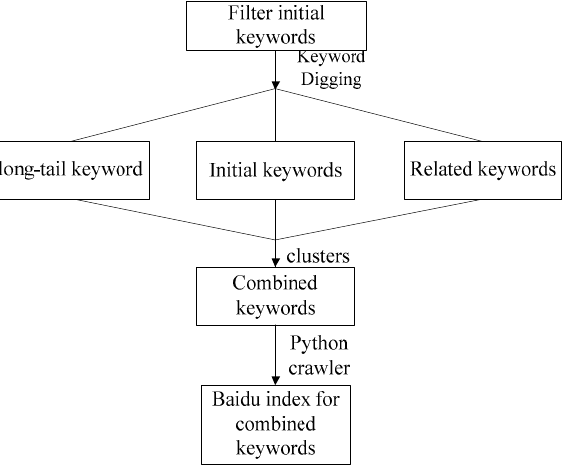
Figure 2. Flow chart of keywords selection of real estate market information.